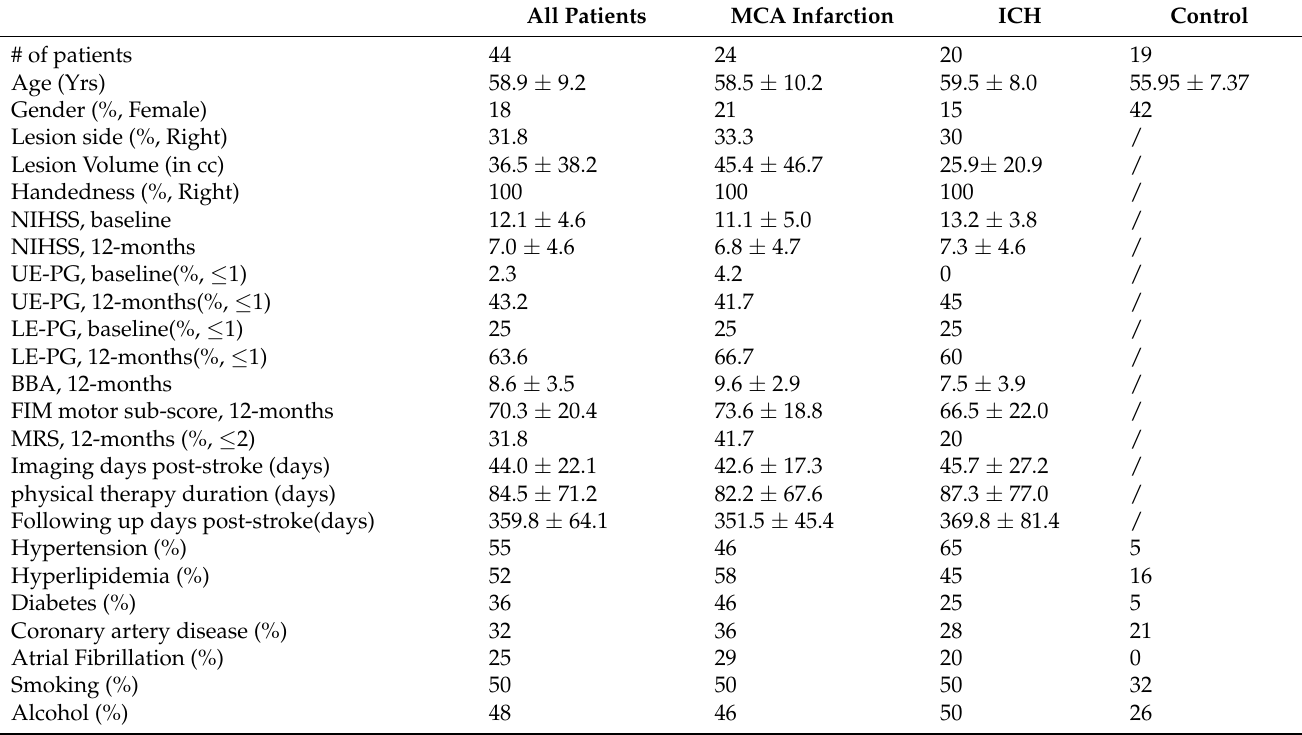
Table 1. Patients’ Demographical and Clinical Data Characteristics.